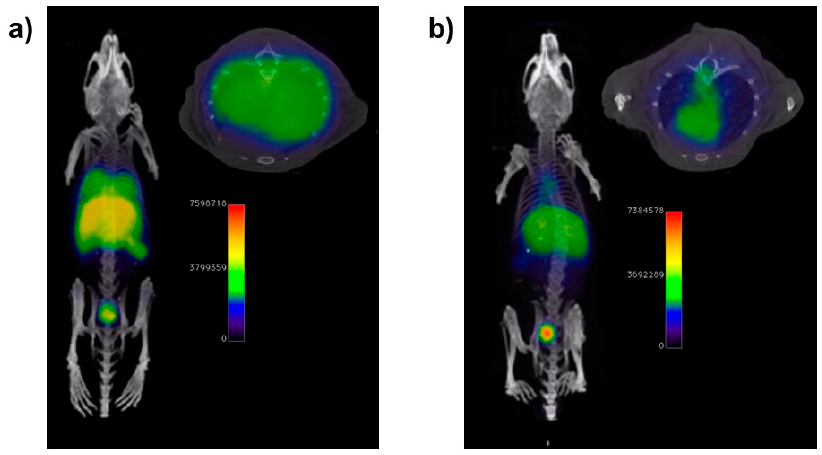
Figure 6. ( a ) PET/CT imaging of a mouse with LPS-induced lung inflammation 1 h post i.v. injection of 68 Ga nanoradiotracer functionalized with N-cinnamoyl-F-(D)L-F-(D)L-F (cFLFLF). Neutrophil recruitment in the lungs is clearly observed. ( b ) PET/CT image of a neutrophil-depleted, LPS-treated mouse 1 h post i.v. injection of 68 Ga nanoradiotracer functionalized with cFLFLF.